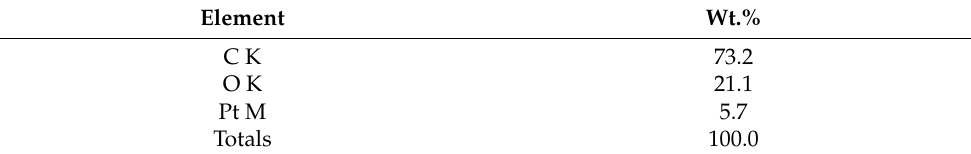
Table 2. The total elemental composition of PtrGO3 determined by EDX, corresponding to Figure 1d [34].